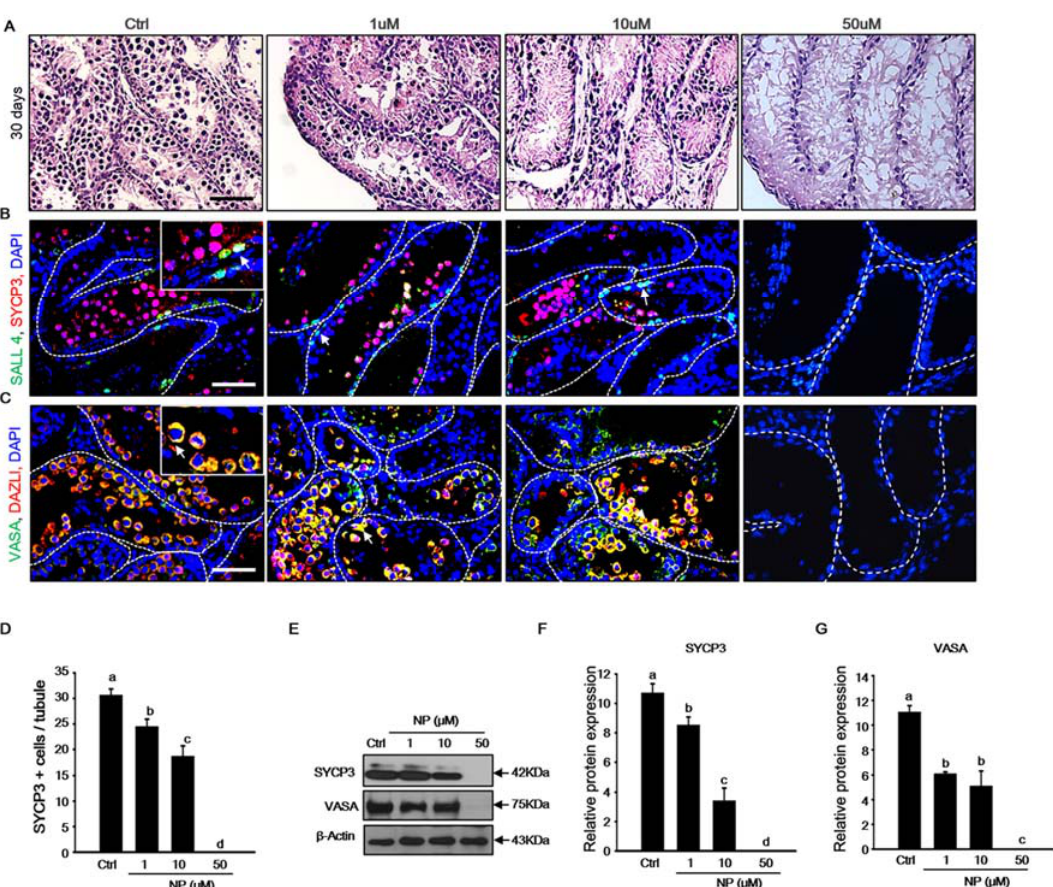
Figure 3. Toxic effect of nonylphenol (NP) on germ cell development. ( A ) Histological features of the mouse testicular fragments (MTFs) cultured for 30 days with 0, 1, 10, and 50 µ M NP. ( B ) Meiotic and undi ff erentiated germ cells co-stained with SYCP3 and SALL4 antibody to confirm the occurrence of meiosisandthesurvivalofundi ff erentiatedgermcellsinNP-exposedMTFs. SYCP3-andSALL4-positive MTFs. ( C ) MTFs co-stained with the germ cell markers VASA and DAZL in the presence and